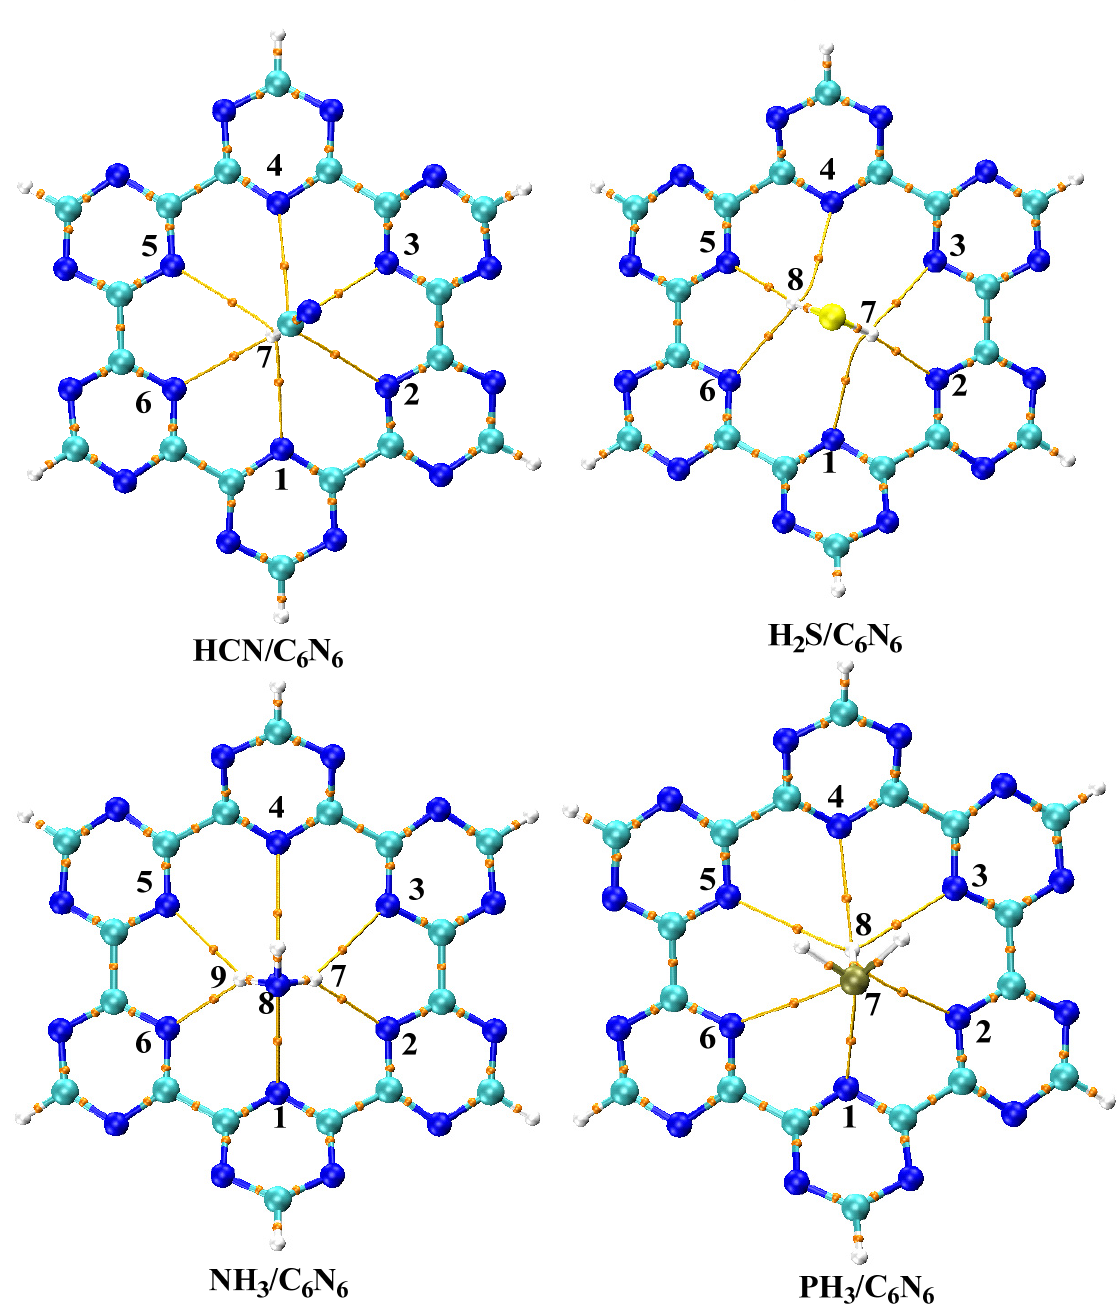
Figure 5. Topological analysis of analyte@C 6 N 6 complexes obtained through QTAIM analysis.